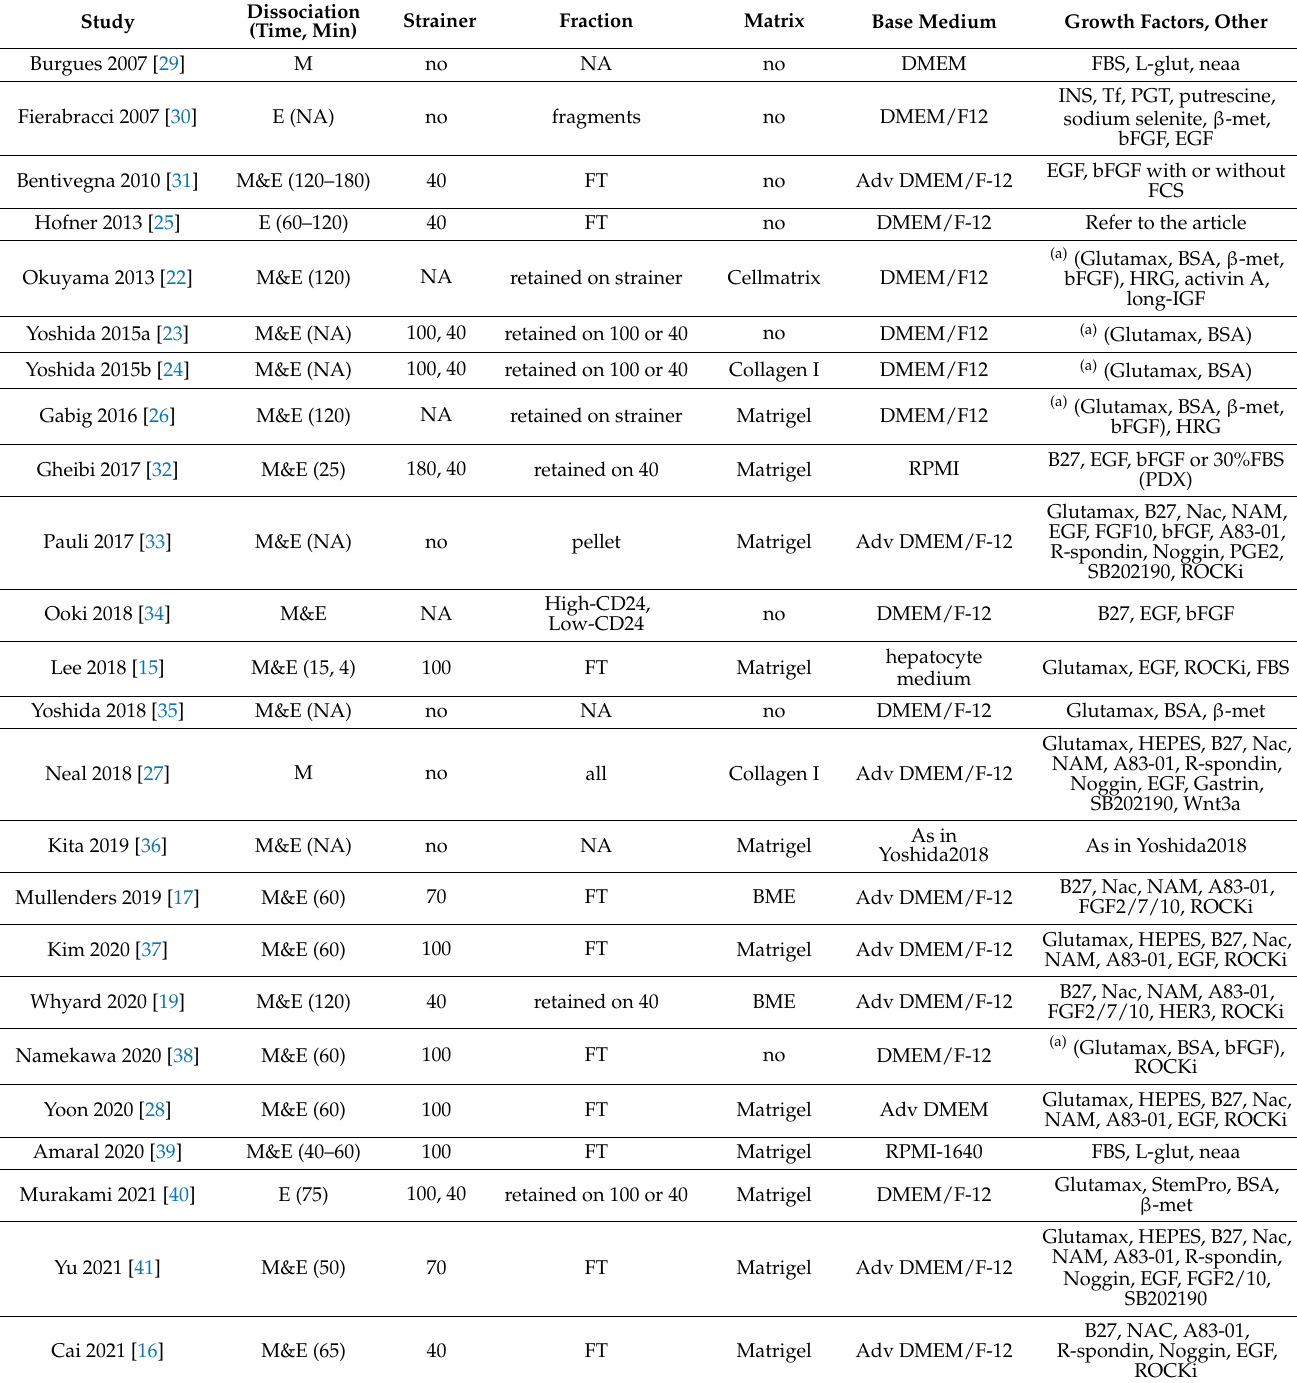
Table 2. Sample processing and culture